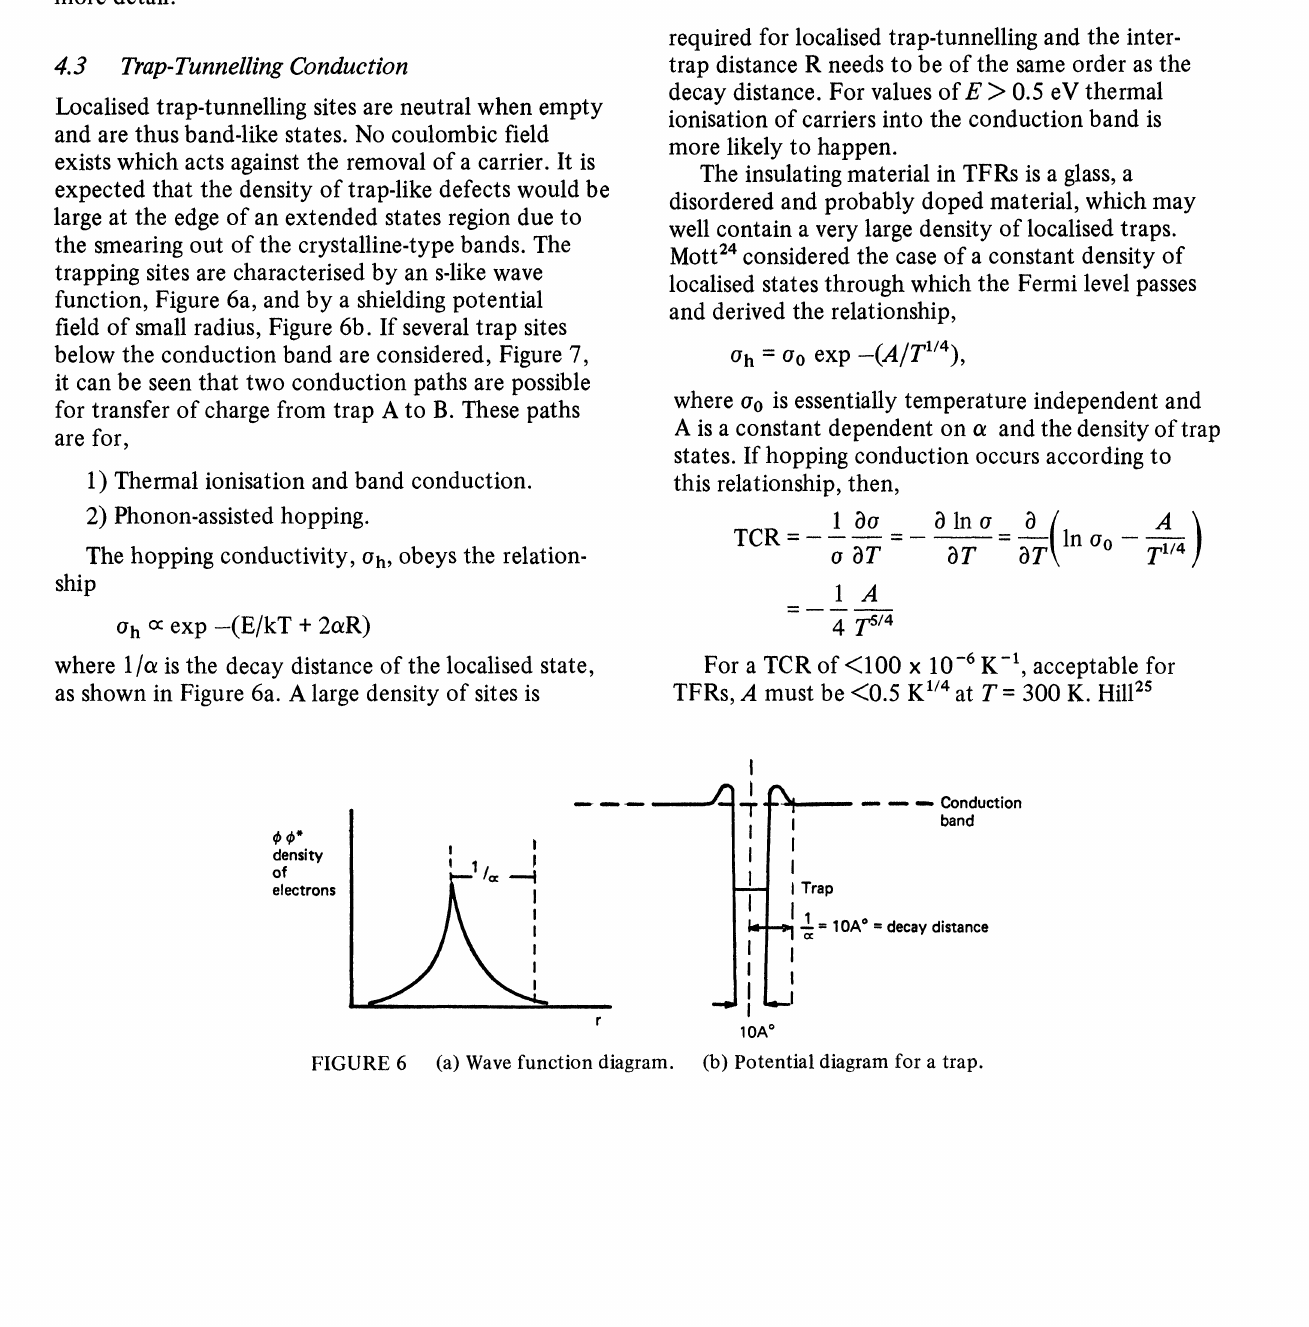
(a) Wave function diagram. (b) Potential diagram for a